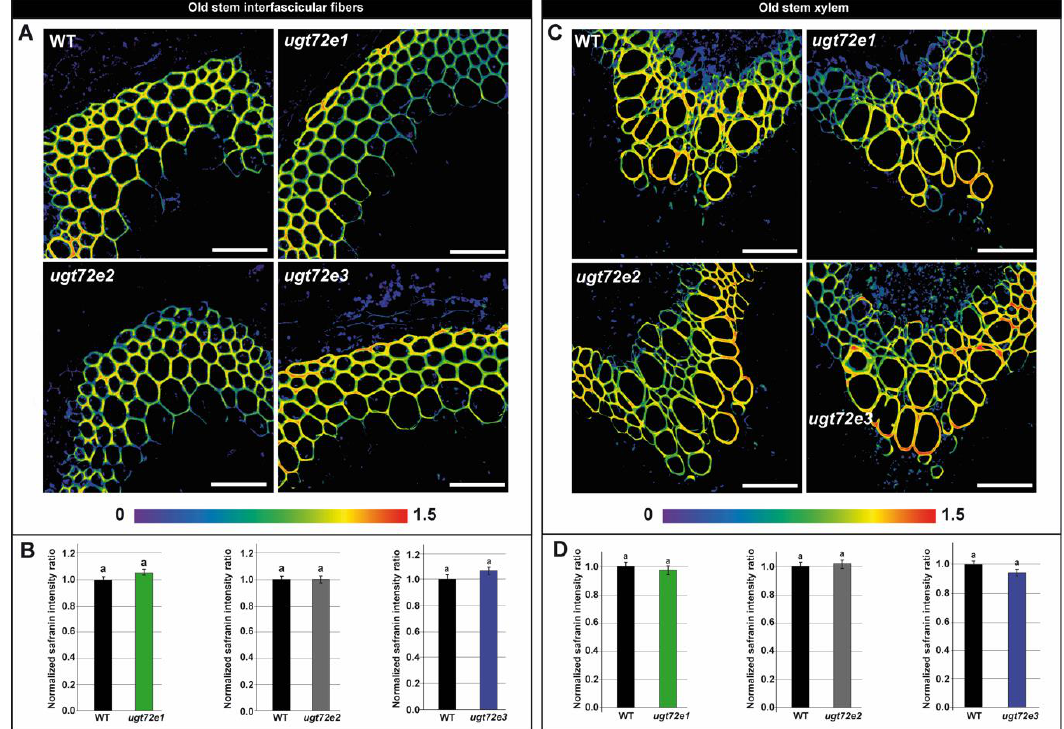
Figure 5. Local lignin content determination on the old parts of the floral stems using safranin O fluorescence-based method on WT and ugt72e mutants. The safranin O ratiometric images are shown in ( A ) and ( C ). The color range used for image representation varies from the non-normalized ratio 0 (purple) to non-normalized ratio 1.5 (red). Scale bar = 50 µm. Quantification was performed on interfascicular fibers ( B ) and xylem ( D ). The normalized safranin intensity ratios (± SD) are represented. Means (± SD) with the same lowercase letters are not significantly different according to Student t-test ( p -value < 0.01, n = 3).